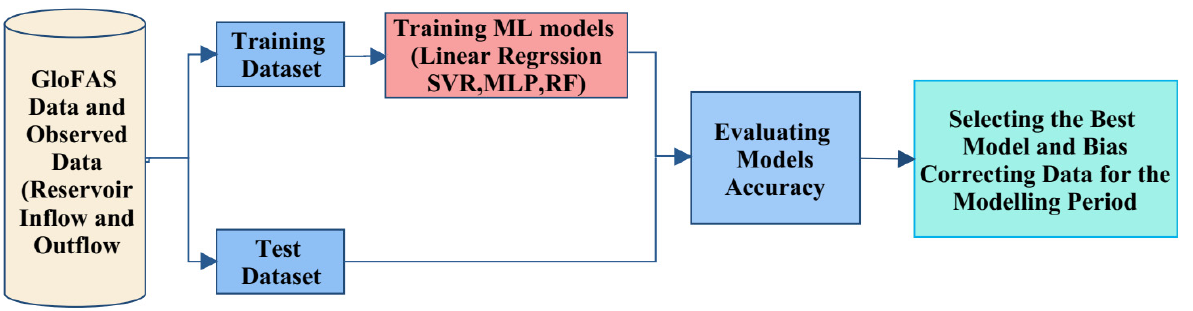
Figure 4. Bias correction process for inflow and outflow data.